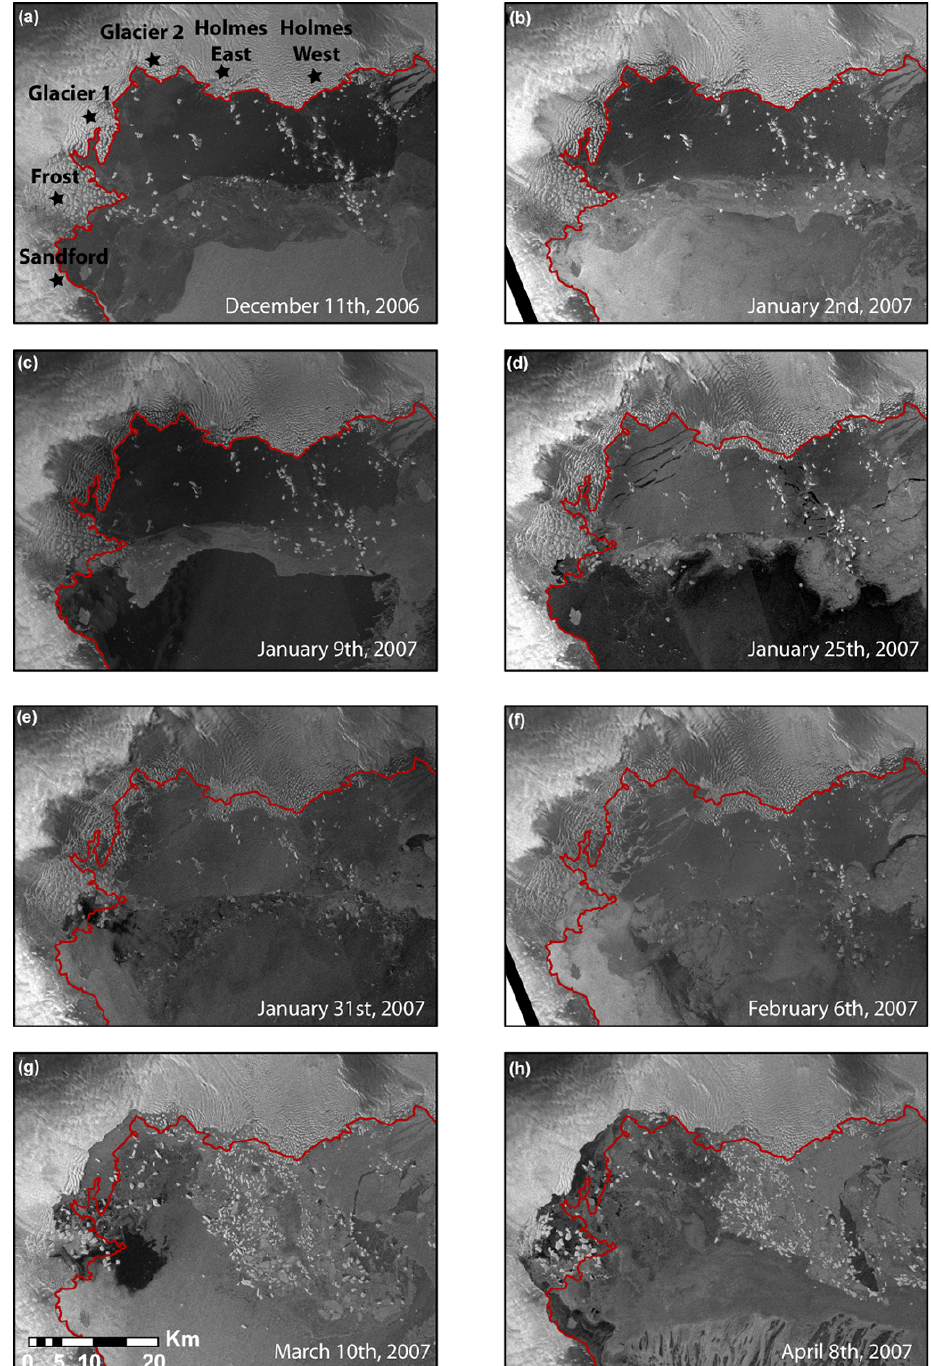
Figure 4. Envisat ASAR WSM imagery showing the evolution of the 2007 calving event. Red line shows the terminus positions from 11 December 2006 on all